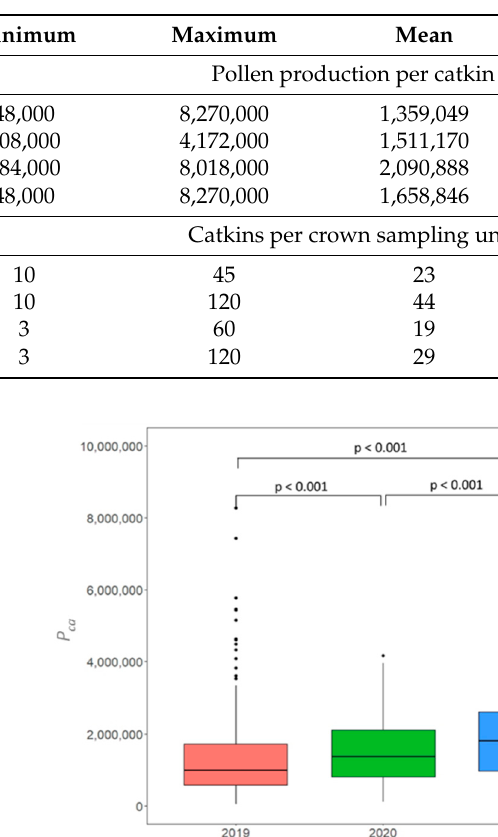
Table 2. Descriptive statistics of pollen production per catkin ( P ca ) and catkins per crown sampling unit ( C su ; 0.125 m 3 ) (minimum, maximum, mean, median and standard deviation) estimated from 28 selected birch trees of the seed plantation Wildberg during 2019–2021.